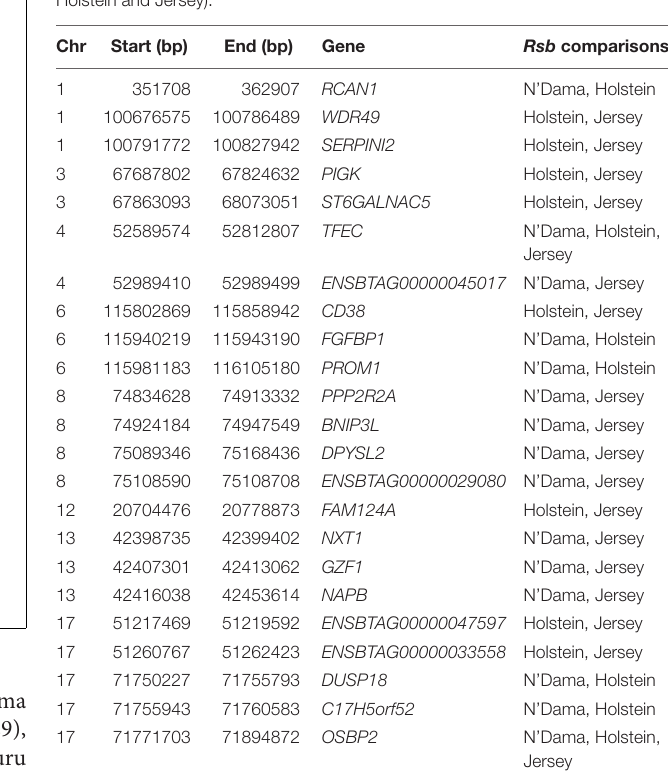
TABLE 3 | List of overlapping candidate genes detected by Rsb analysis following the comparison of Muturu with each of three other taurine breeds (N’Dama, Holstein and Jersey).